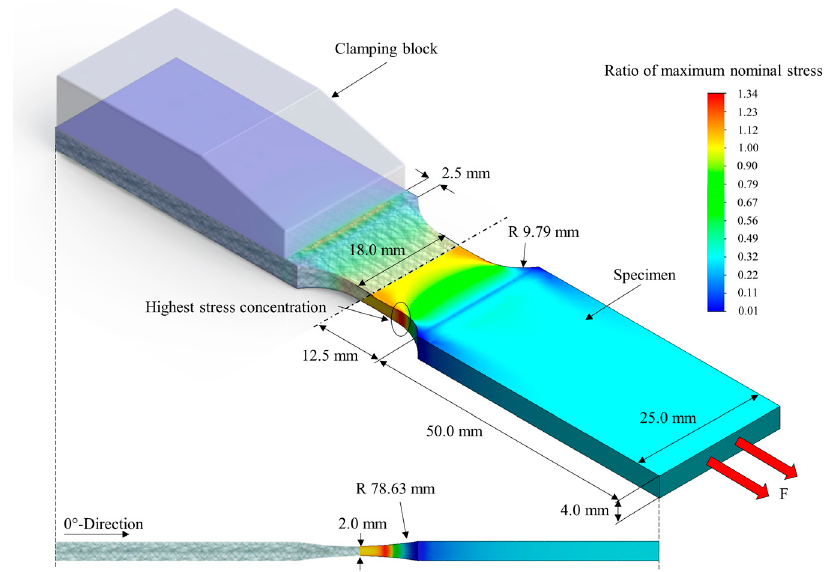
Figure 2. Fatigue specimen design and exemplary tensile stress concentration factor (SCF) distribution during testing.